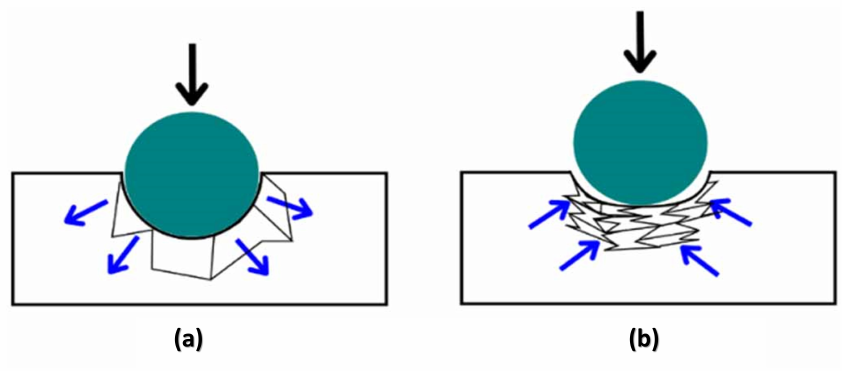
Figure 4. Deformation behavior and indentation resistance of: ( a ) conventional material and ( b ) aux- etic material. Reprinted with permission from Ref. [89]. Copyright 2021,